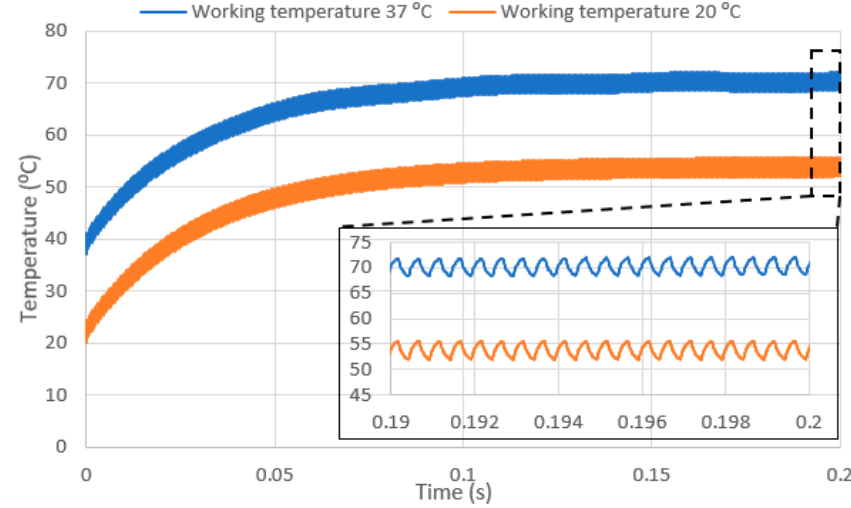
Figure 7. Temperature profile of the aluminum actuating bridge at 0.314-W power input. The inset enlarges the temperature profiles from 0.19 s to 0.2 s.